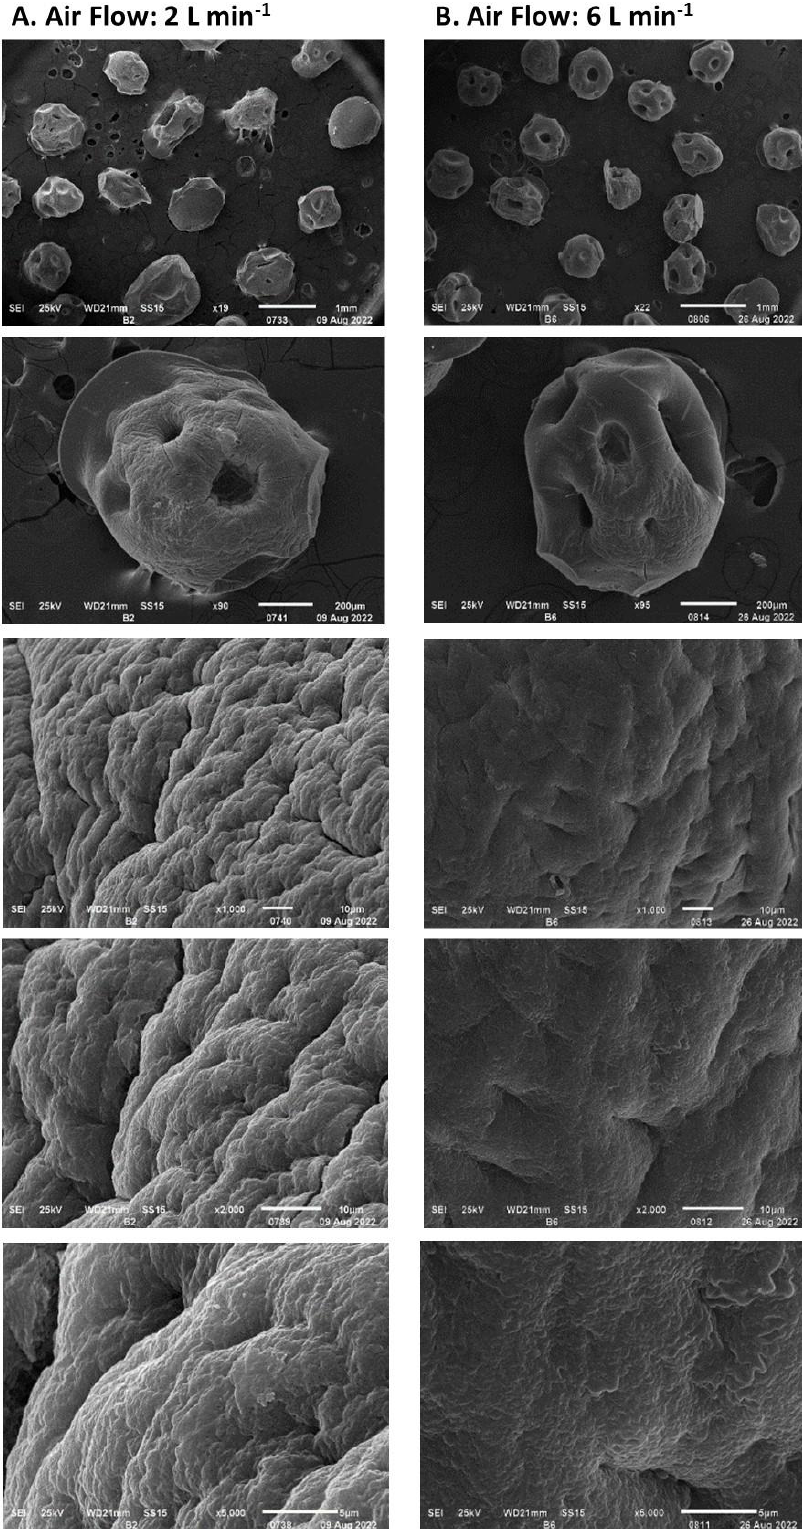
Figure 9. Calcium alginate capsules dehydrated with airflow (( A ). 2 L min −1 , ( B ). 6 L min −1 ) at room temperature.